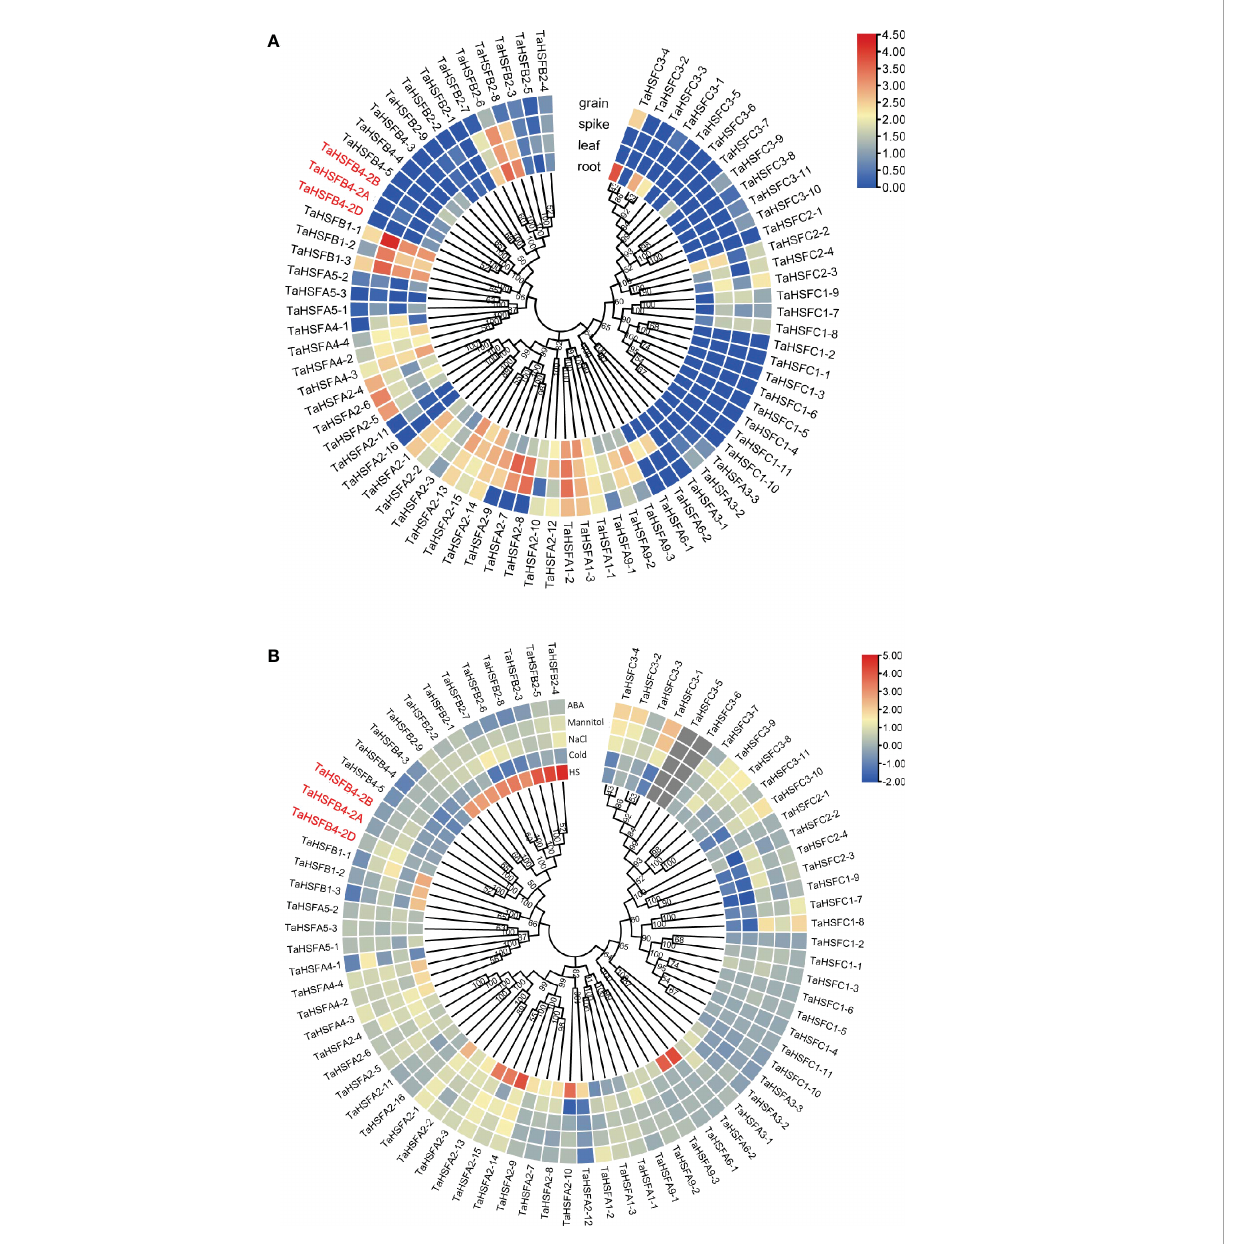
FIGURE 3 Expression analysis of TaHSFs genes in different tissues and stress treatments. (A) Expression analysis of TaHSFs genes in different tissues based on public data. Bar scale: log 2 TPM. (B) Expression analysis of TaHSFs genes under different abiotic stress treatments, including heat stress (HS), cold stress (cold), salinity induced stress (NaCl), mannitol-induced dehydration stimulating drought stress (mannitol), and ABA stress (Mittal et al.). Bar scale: log 2 FC, FC: fold change compared with the mock